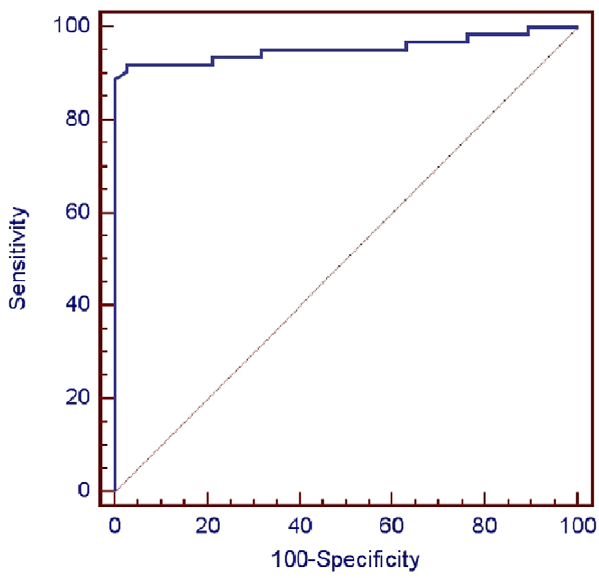
Figure 3. ROC (Receiver Operating Characteristic) curve of eIF2B GEF activity regarding the diagnosis of eIF2B-related disorders. The ROC curve analysis was performed to determine the optimal threshold of GEF activity which best discriminates between eIF2B-mutated (n=63) and eIF2B-unrelated leukodystrophic patients (n=38). The # 77.5% threshold achieves 100% specificity (95% CL=90.7–100%) and 88.9% sensitivity (95% CL=78.4–95.4%). The area under the ROC curve (AUC) =0.955; standard error =0.0244; 95% confidence interval: 0.894 to 0.986; test for the: AUC =0.5, p=0.0001.